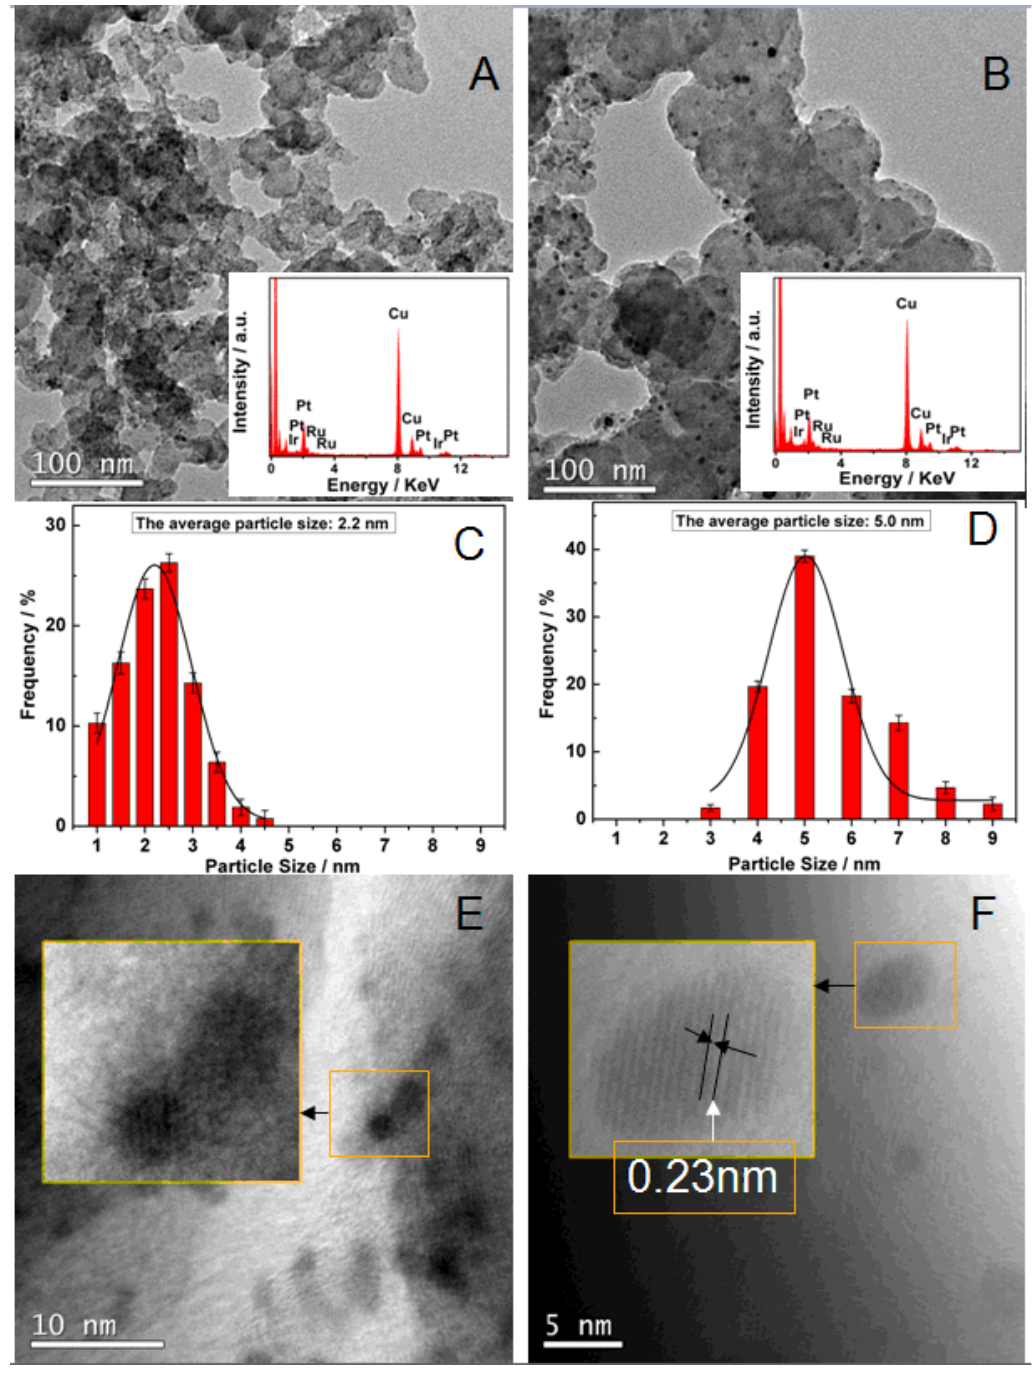
(0.75 V vs. RHE) of the PtRuIr /C is 70 mV more positive than that of PtRuIr c suggesting faster hydroxyl desorption from the PtRuIr /C surfaces [27]. c Figure 2. TEM, the corresponding particle size distributing histogram and HRTEM images of PtRuIr /C ( A , C , E ) and PtRuIr /C ( B , D , F ) catalysts. Inset of ( A ) and ( B ): EDX spectrum a c of the PtRuIr /C ( A ) and PtRuIr /C ( B ) a c